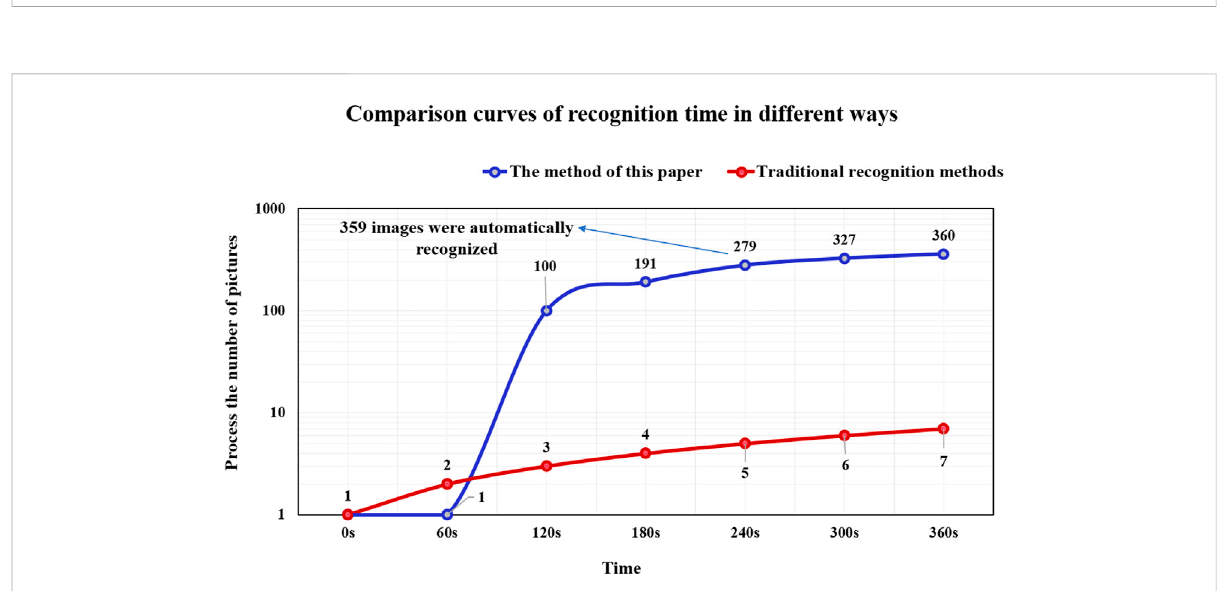
FIGURE 9 Recognition time